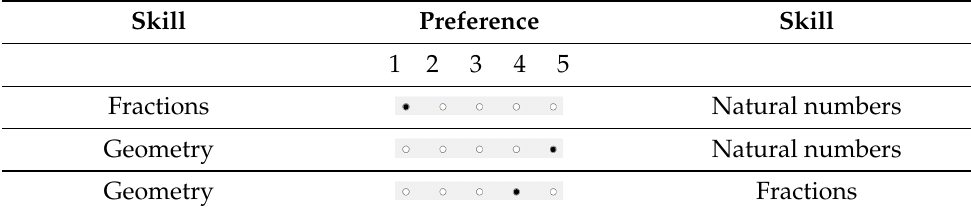
Table 2. An example student’s preferences over